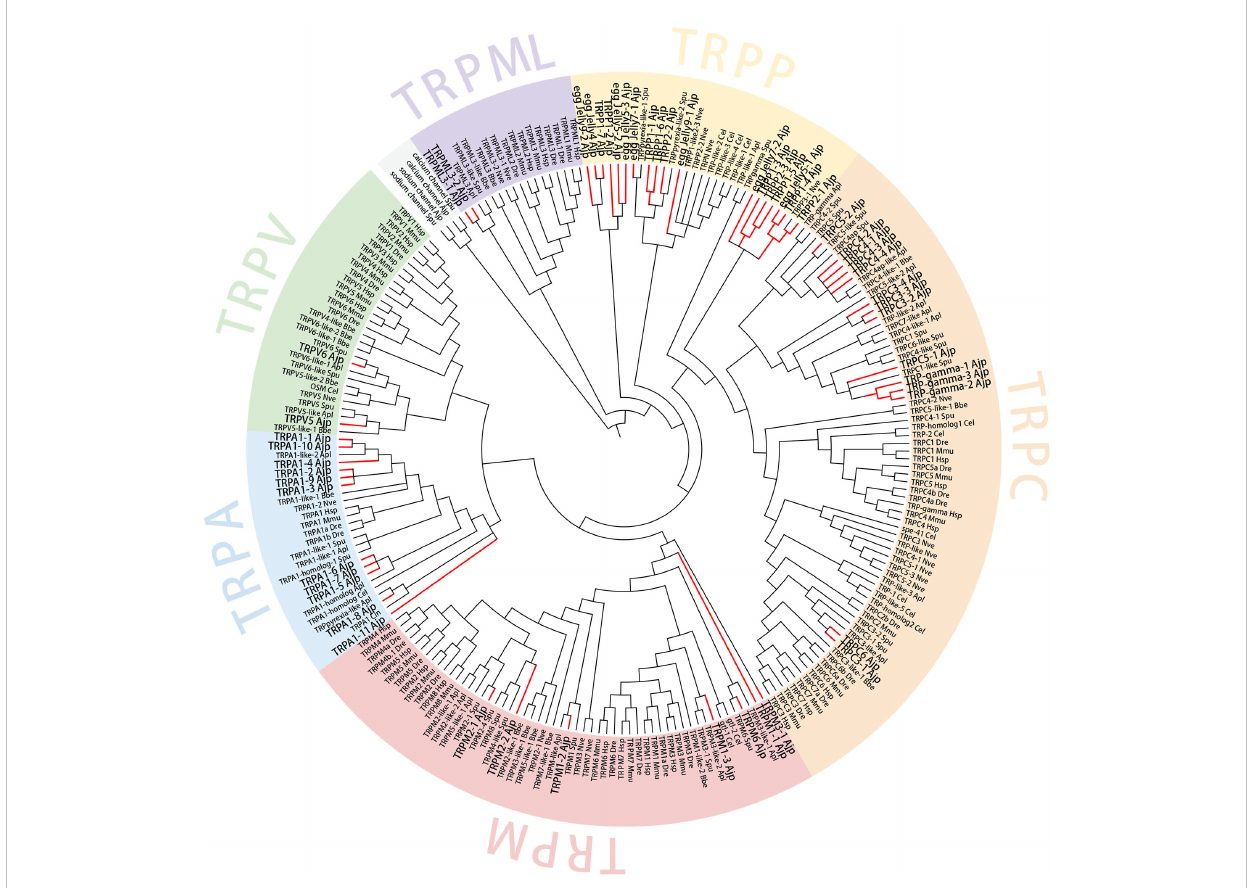
FIGURE 4 Phylogenetic analysis of TRP genes. AjTRPs are highlighted with red branches and enlarged font. Sodium channel protein of A. japonicus and S. purpuratus and calcium channel protein of A. japonicus and S. purpuratus sequences were included as outgroups. Accession numbers for all sequences are provided in Supplementary Table S1. Hsp, Homo sapiens ; Mmu, Mus musculus ; Dre, Danio rerio ; Cel, Caenorhabditis elegans ; Bbe, Branchiostoma belcheri ; Apl, Acanthaster planci ; Spu, Strongylocentrotus purpuratus ; Nve, Nematostella vectensis ; Ajp, Apostichopus japonicus